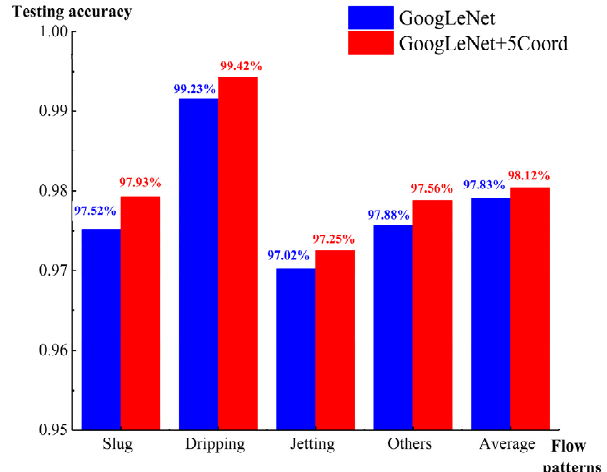
Figure 8. Testing accuracy of GoogLeNet+5 Coord and GoogLeNet.